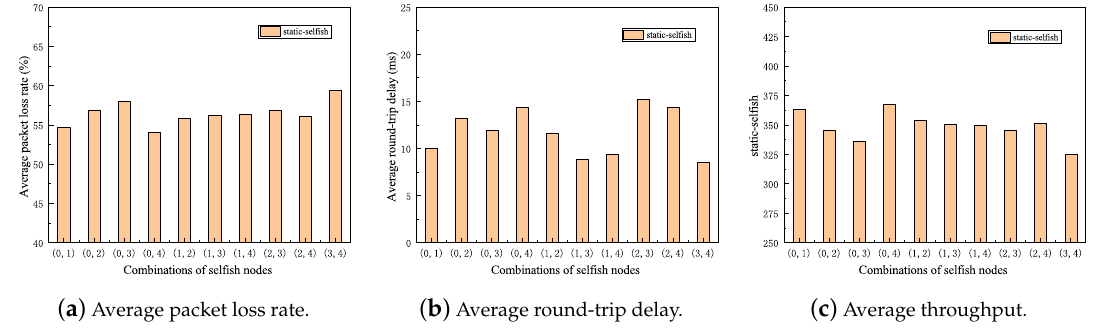
Figure 9. Performance impact of different combinations of static selfish nodes (5